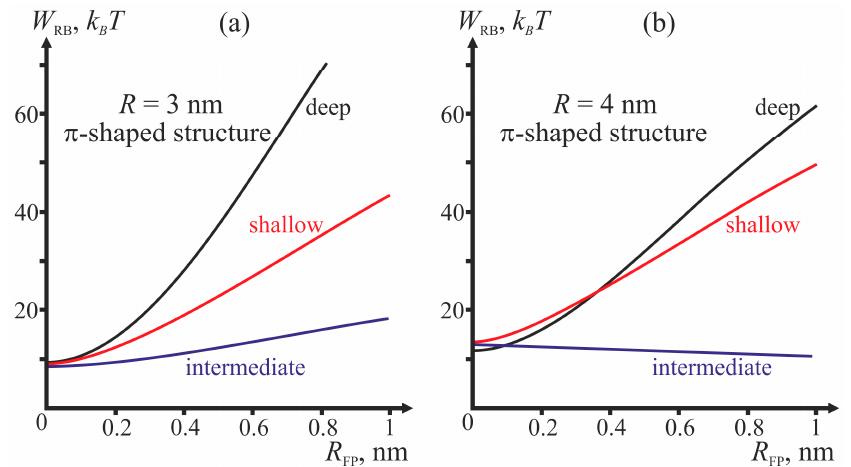
Figure 6. Dependence of the energy barrier for transition from the π -shaped structure to the initial unperturbed state ( W RB ) on the half-width of the fusion peptide R FP for different fusion rosette radii. ( a ) R = 3 nm; ( b ) R = 4 nm. The red, blue and black curves correspond to shallow, intermediate and deep insertion, respectively.